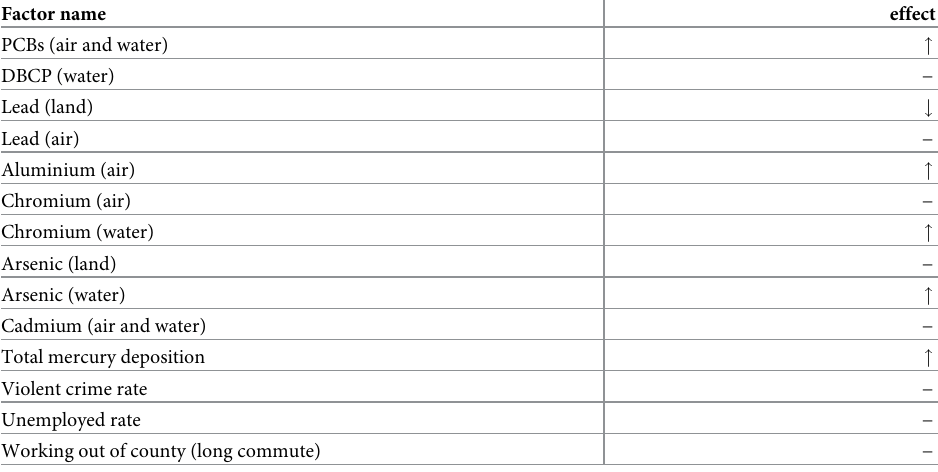
Table 3. Test results for factors selected from the literature reports (Table 1). We included a factor only if both its Δ IC and the coefficient of at least one of its septiles was statistically significant.